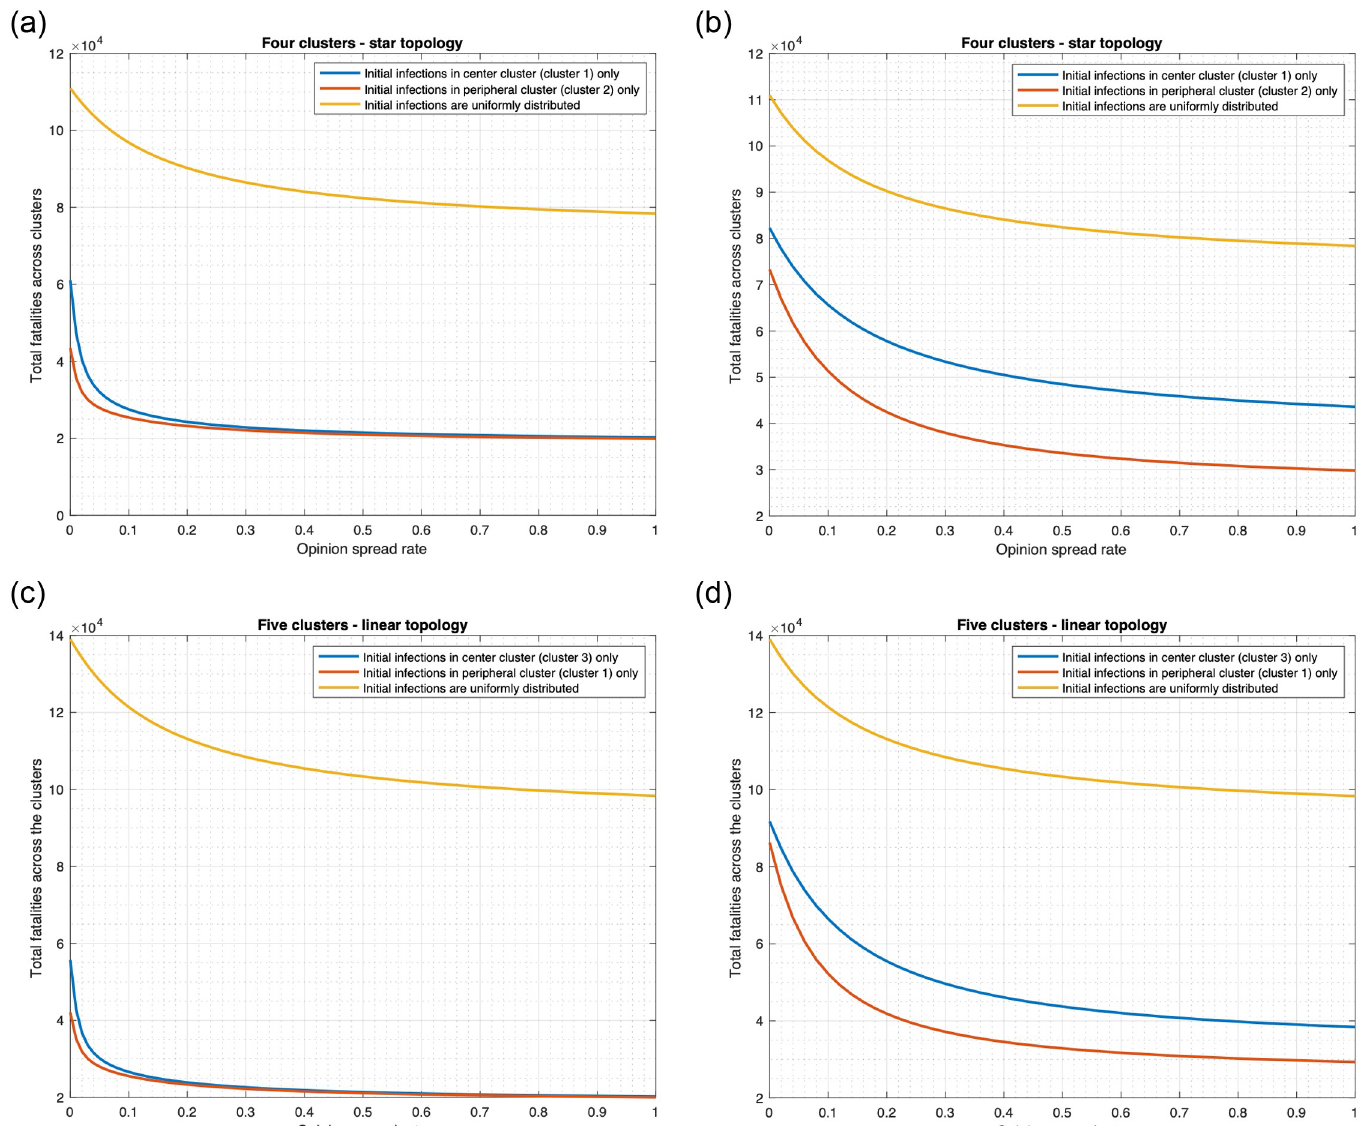
Fig 8. Relationship between fatality and opinion spread rate (multiple clusters). (a) Star topology, κ = 0.01. (b) Star topology, κ = 0.8. (c) Linear topology, κ = 0.01. (d) Linear topology, κ = 0.8.